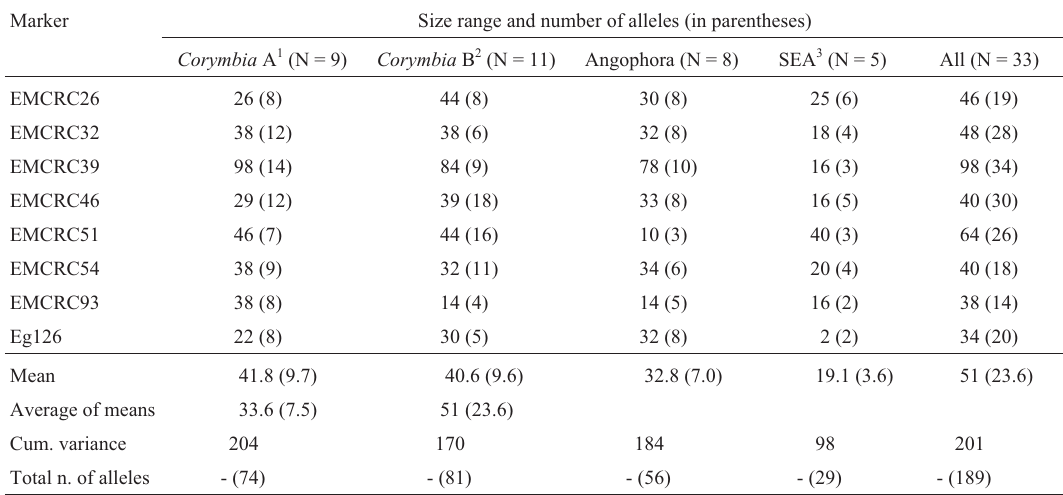
Table2 -Numbers,sizerangesandcumulativevariancesforSSRallelesobservedineachinformalgroupinthisstudy.Theobservednumberofallelesat each locus is given in parentheses. Cumulative variances are based on absolute allele sizes. Marker Size range and number of alleles (in